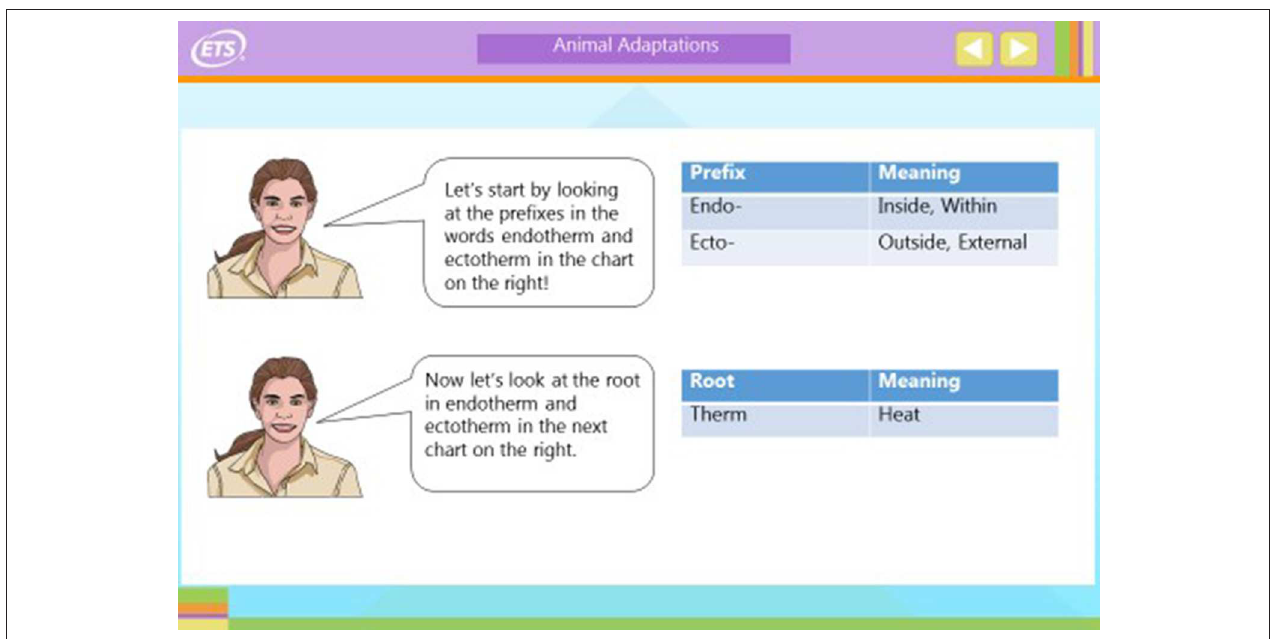
FIGURE 5 | Example 1 of scaffolding activities to learn construct-relevant vocabulary.